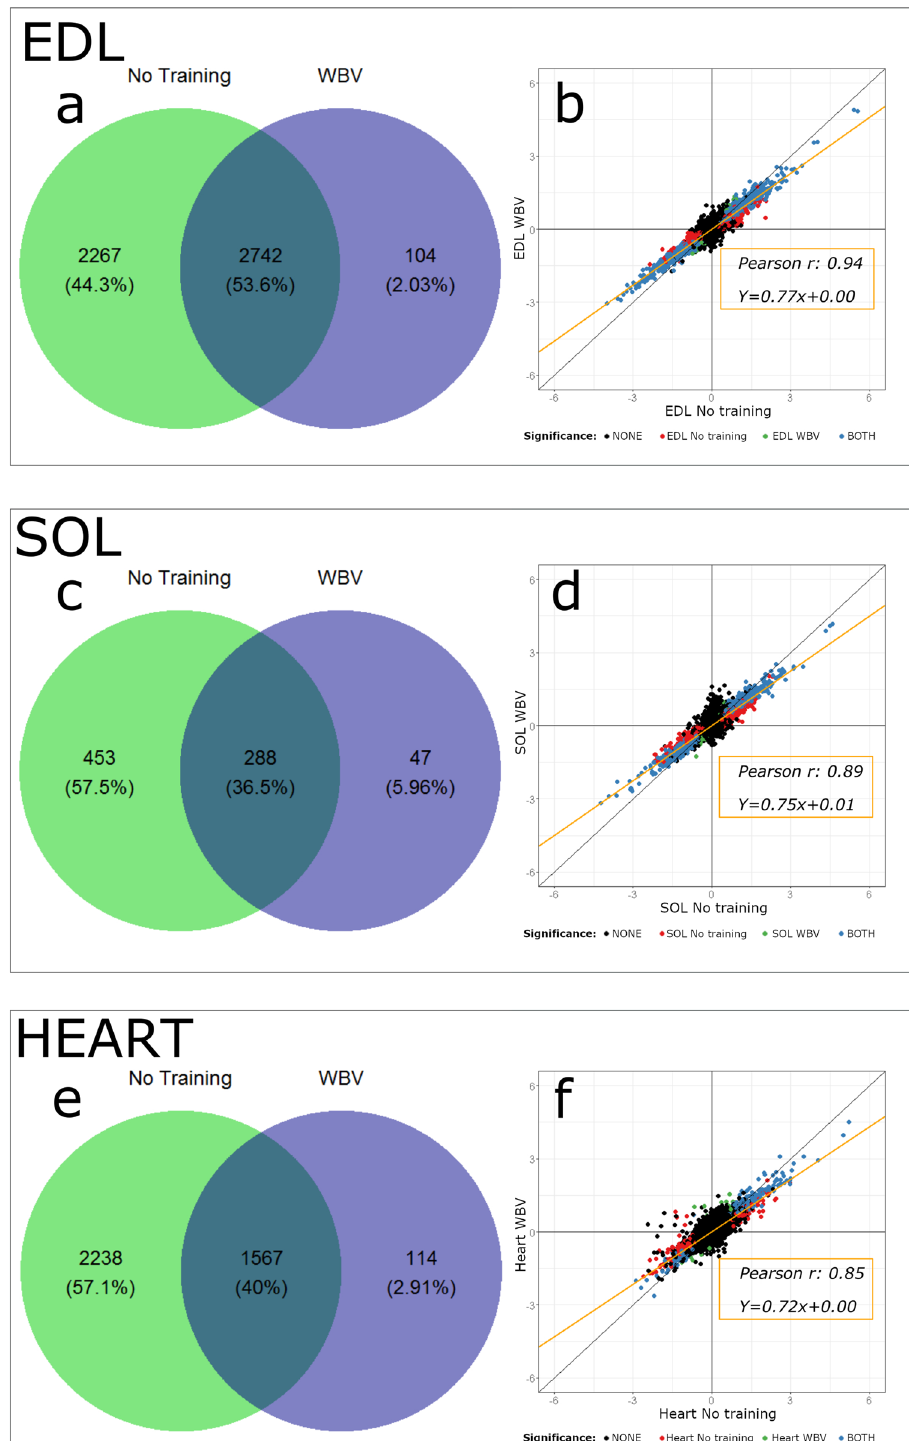
Figure 7. Microarray results showing the comparison of C with T and T + WBV group for three different tissues: EDL ( a,b ), SOL ( c,d ), and heart ( e,f ). Venn diagrams ( a,c,e ) display number of genes with q < 0.01 in T (green) and WBV (blue) mice. Scatter plots ( b,d,f ) show a correlation and linear regression of log-ratio of all genes from T + WBV (y-axis) and T (x-axis) compared to C mice with colors indicating